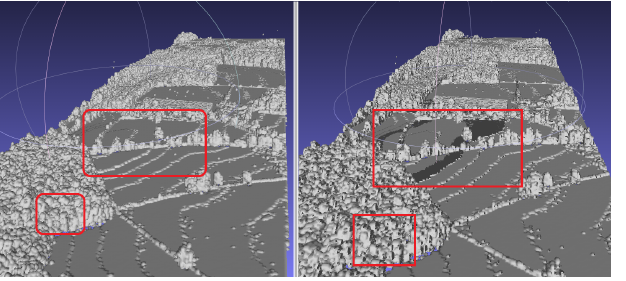
Figure 4. Comparison between including and ignoring neighbouring voxels; holes appear when ignored. The red boxes show two affected areas. The locations of the red boxes is an approximated association between the two polygons, since the orientation of the polygons slightly varies.